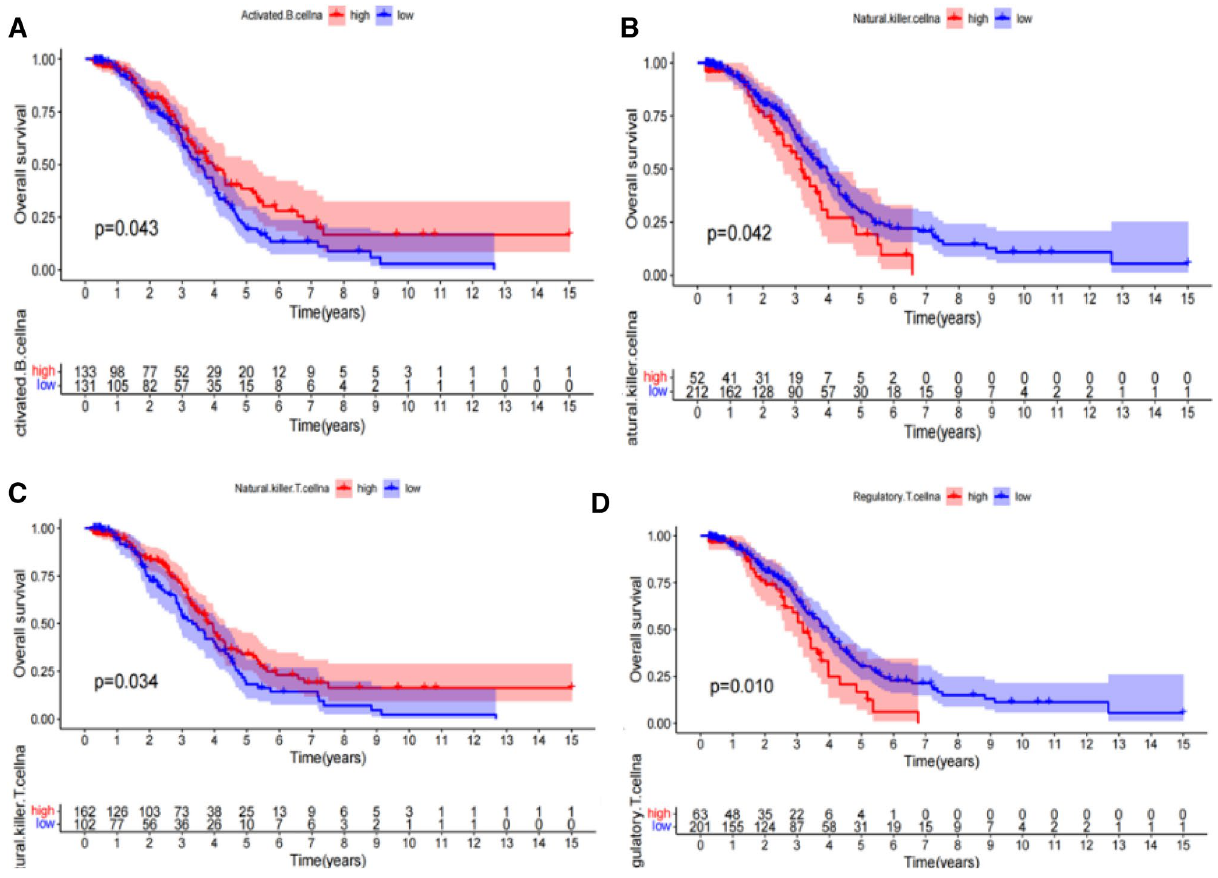
Figure 6. Kaplan–Meier survival curve of patients with survival-related immune cells. High expression of activated B cell ( A ) and natural killer T cell ( C ) was beneficial to the prognosis of patients, while natural killer cell ( B ) and regulatory T cell ( D ) was on the